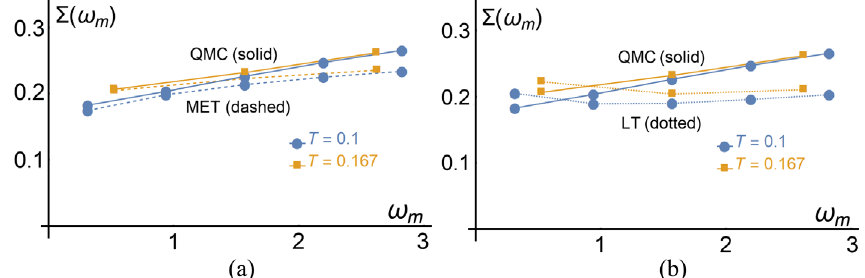
FIG. 9. Fermionic self-energy of the Ising-nematic model. (a) Comparison of the MET and QMC self-energy. (b) Comparison of the LT and QMC self-energy.